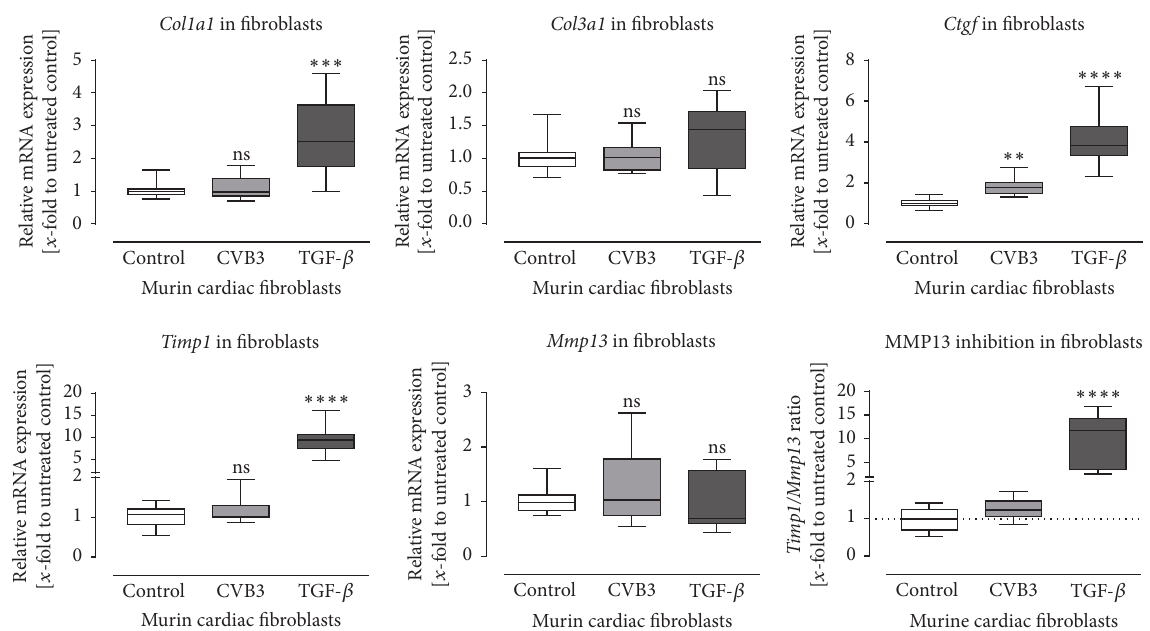
Figure 7: Gene expression analysis of murine cardiac fibroblasts after infection with CVB3 or stimulation with TGF- 𝛽 . Altered gene expression of profibrotic genes was detected in cardiac fibroblasts in response to stimulation with 5ng/mL TGF- 𝛽 for 24 hours but not after infection with 0.5 MOI CVB3 for 24 hours. The mRNA expression of Col1a1 , Ctgf, and Timp1 was significantly upregulated after TGF- 𝛽 stimulation but remains unchanged for Col3a1 and Mmp13 . Except for a slightly increased expression of Ctgf the viral infection with CVB3 did not result in a profibrotic gene expression within 24 hours after infection. Data are presented as relative mRNA expression ( 𝑥 -fold to untreated control cells) in box plots using the formula 2 −ΔΔ Ct ; ∗ significantly different compared to untreated control cells; ∗∗ 𝑃 < 0.01 ; ∗∗∗ 𝑃 < 0.001 ; ∗∗∗∗ 𝑃 < 0.0001 ; ns not